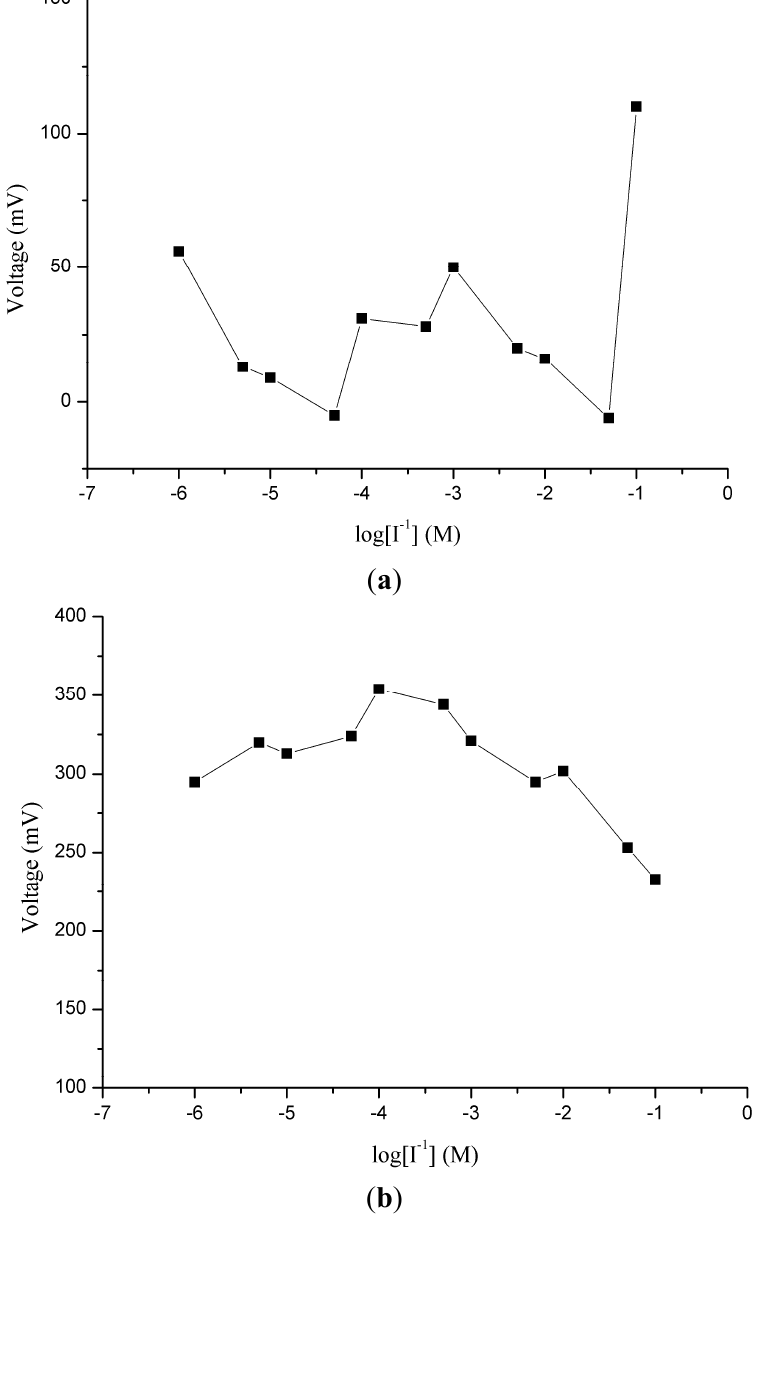
Figure 2. ( a ) The calibration curve of membrane paste of ion exchanger on the gold coated glass for 1 × 10 − 6 − 1 × 10 − 1 M concentration of iodide ion, ( b ) the calibration curve of ion exchanger paste on the gold coated silicon for 1 × 10 − 6 − 1 × 10 − 1 M concentration of iodide ions, ( c ) the calibration curve of selective iodide ion sensor based on the functionalized ZnO nanotubes for 1 × 10 − 6 − 1 × 10 − 1 M concentration of iodide ion, and ( d ) the calibration curve of selective iodide ion sensor based on the functionalized ZnO nanorods for 1 × 10 − 5 − 1 × 10 − 1 M concentration of iodide